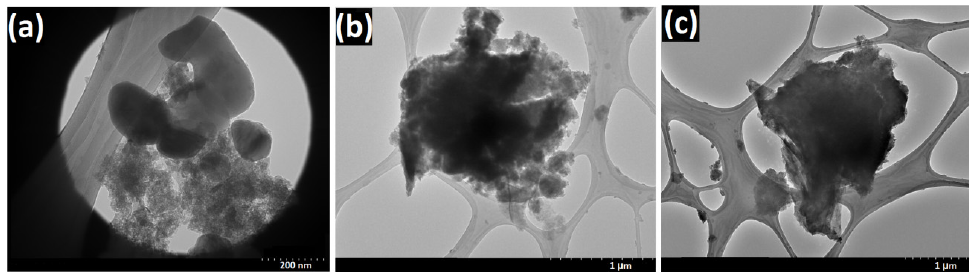
Figure 14. TEM micrographs of corrosion products for ( a ) uncoated; ( b ) MgO ‐ coated and ( c ) Si/MgO ‐ coated after 7 days of immersion in a SBF solution at 37 °C. Si/MgO-coated after 7 days of immersion in a SBF solution at 37 ◦